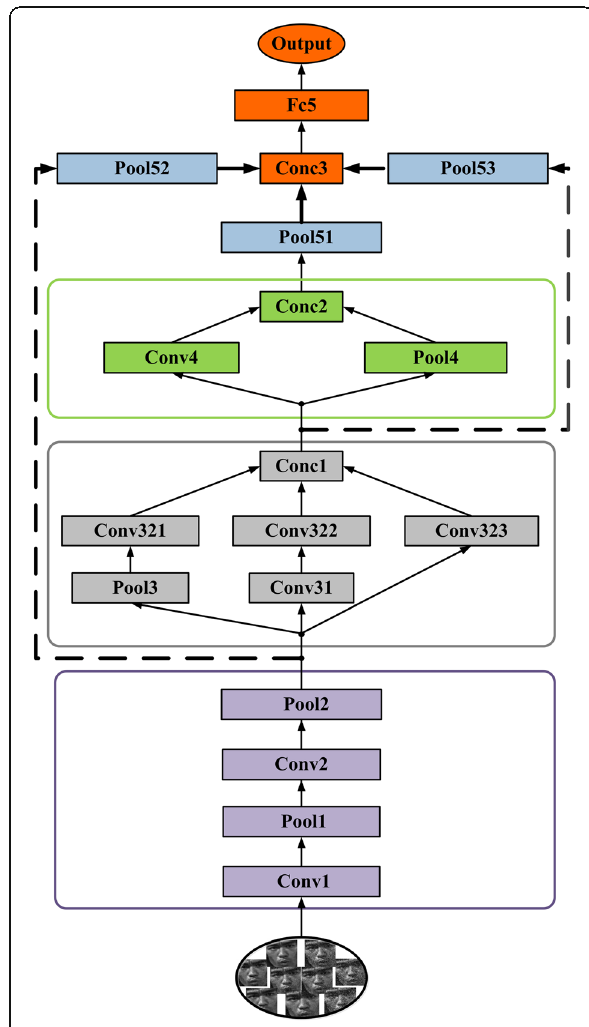
(Fc5). Figure 2 is the overview of the network